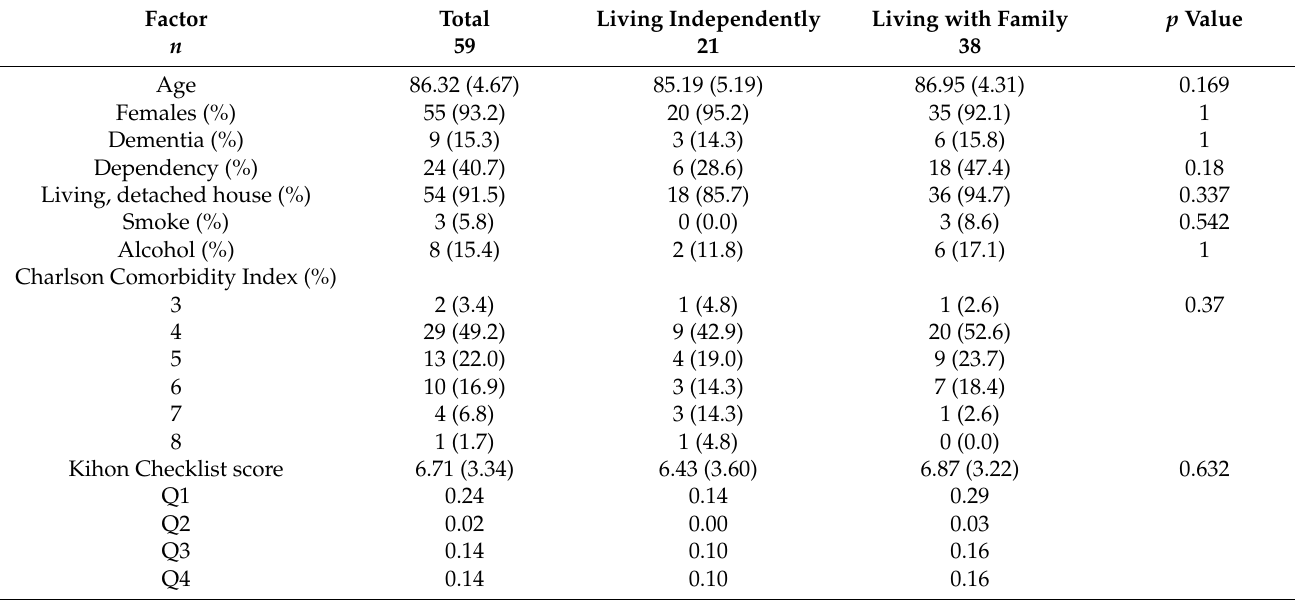
Table 2. Demographic data of